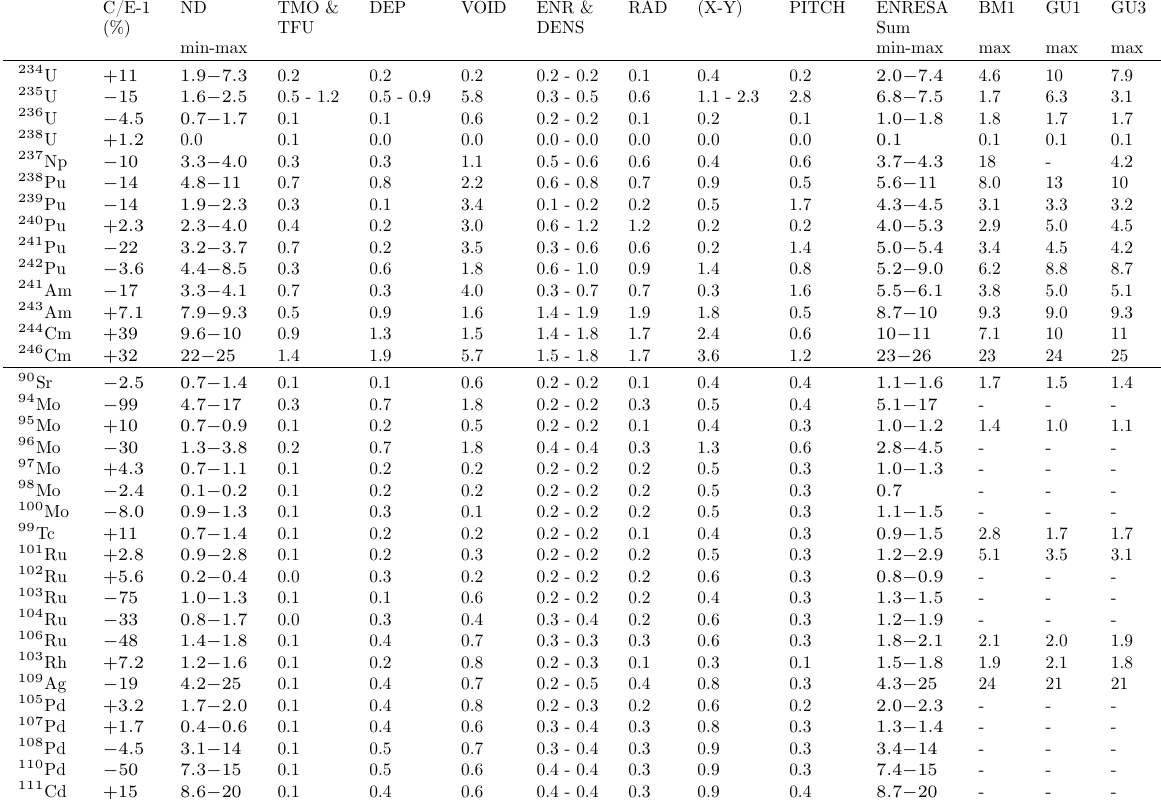
Table A.2. Uncertainty intervals ∆ C from various parameters for the ENRESA-1 sample for the isotopic concentra- tions (CASMO5-1 calculations). All values are in %. The contribution from TFU is between 0.0 and 0.1%. The column Sum is the square root of the quadratic sum of the different